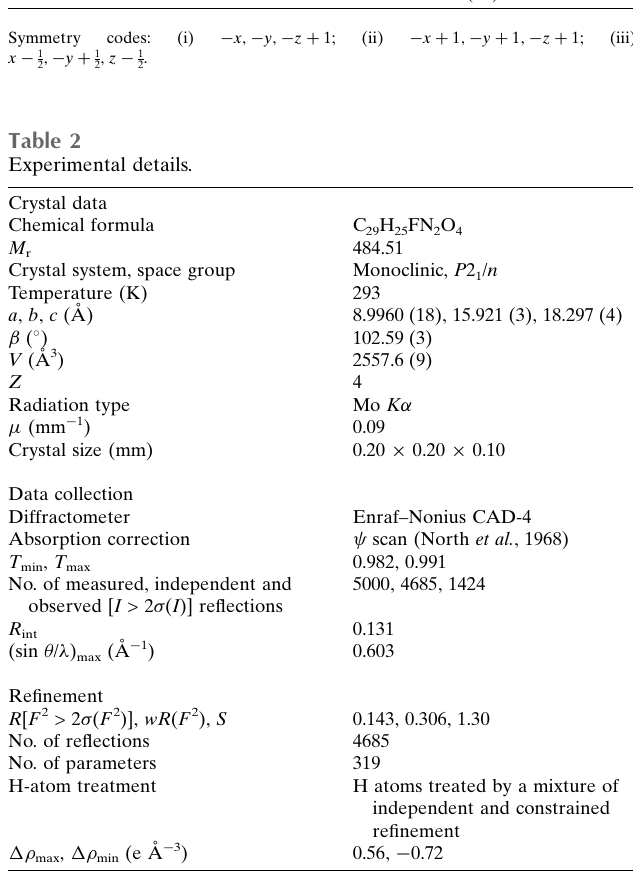
Computer programs: CAD-4 EXPRESS (Enraf–Nonius, 1994), XCAD4 (Harms & Wocadlo, 1995) and SHELXTL (Sheldrick, 2008).